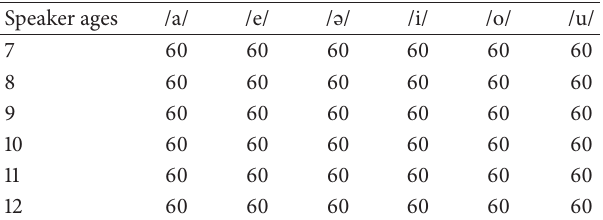
Table 1: Summary of speech